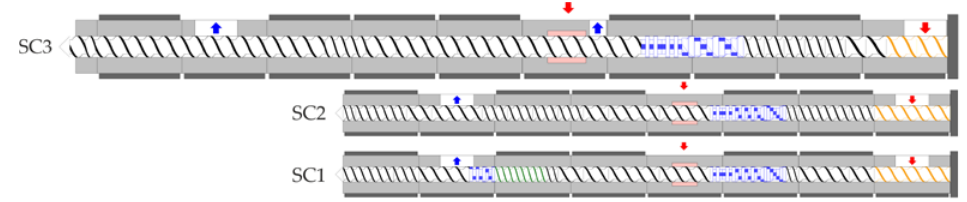
Figure 1. Used screw configurations in the different twin-screw extruders.